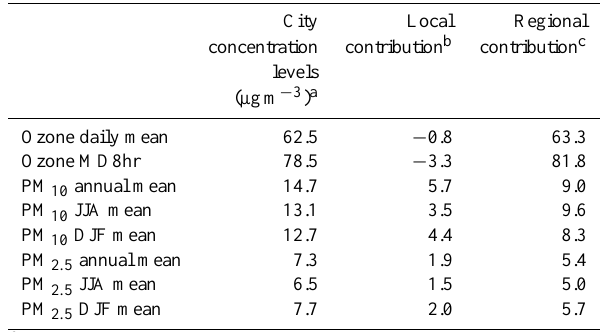
Table 2. Quantification of the regional and local contributions to the present-time concentration levels at the city of